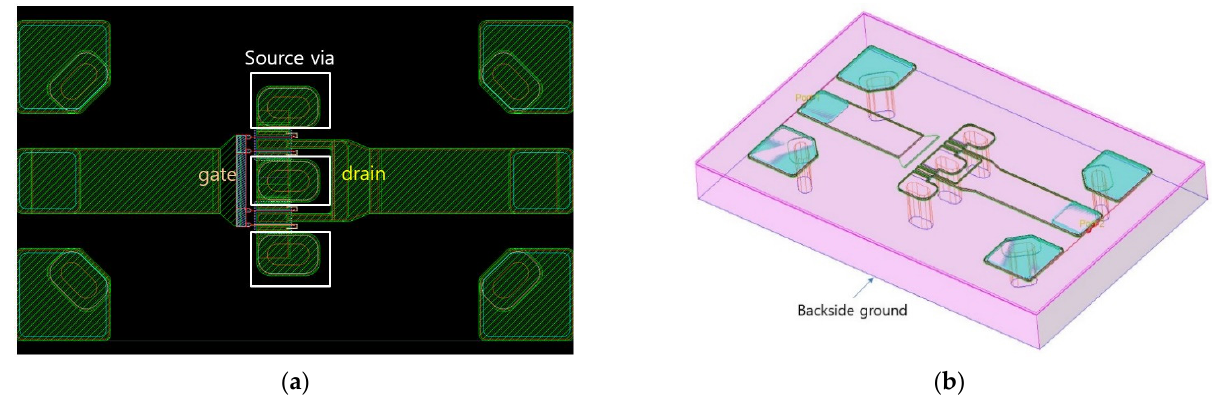
Figure 1. ( a ) Test pattern layout; ( b ) 3D view of 0.15 × 4 × 50 μ m GaN HEMT